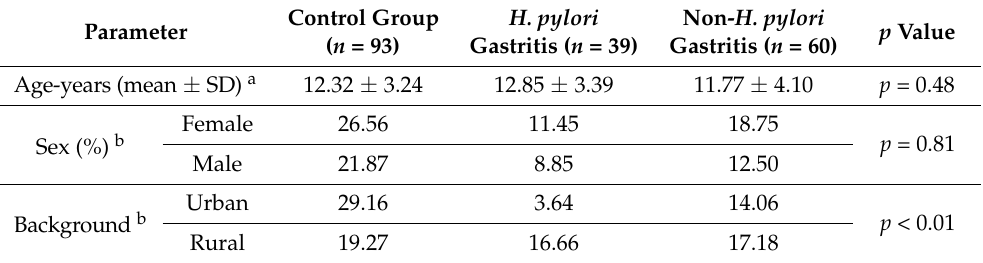
Table 2. Demographic characteristic comparison of controls versus subjects with H. pylori gastritis and non- H. pylori